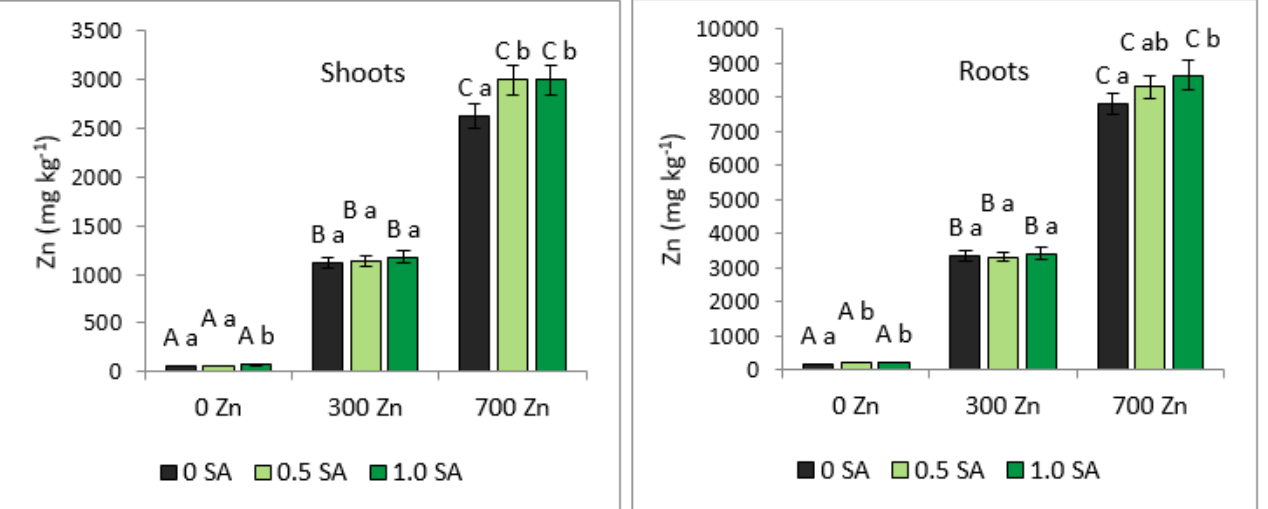
Figure 3. Zn concentration in shoots and roots in Lagwa cultivar–mean over 2 years. Means marked with different capital letters differ significantly between the Zn levels within each level of SA, and means marked with different small letters differ significantly between the SA levels within each level of Zn (according to Tukey’s HSD test at p < 0.05). Vertical bars represent standard errors (n = 4).